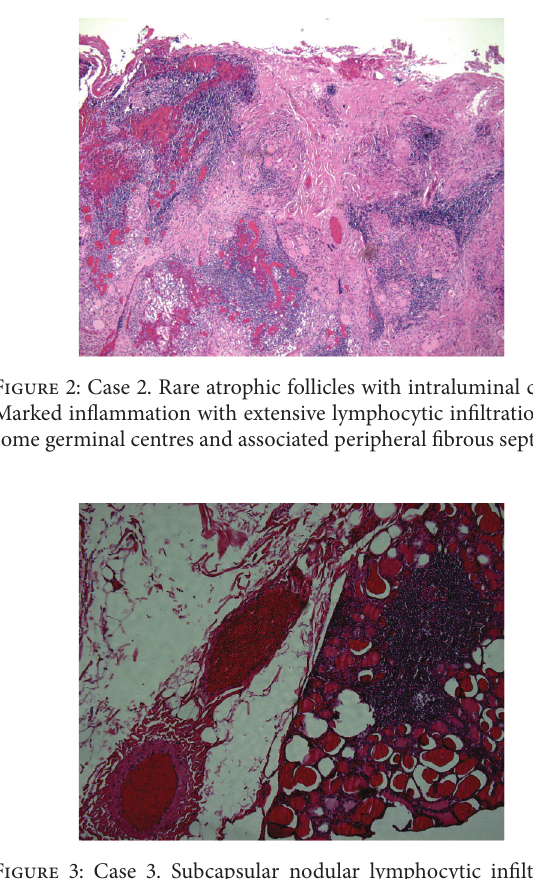
Figure 3: Case 3. Subcapsular nodular lymphocytic infiltration, medium-large sizethyroid follicles with intraluminal colloid. On the left side perithyroidal adipose tissue with congested